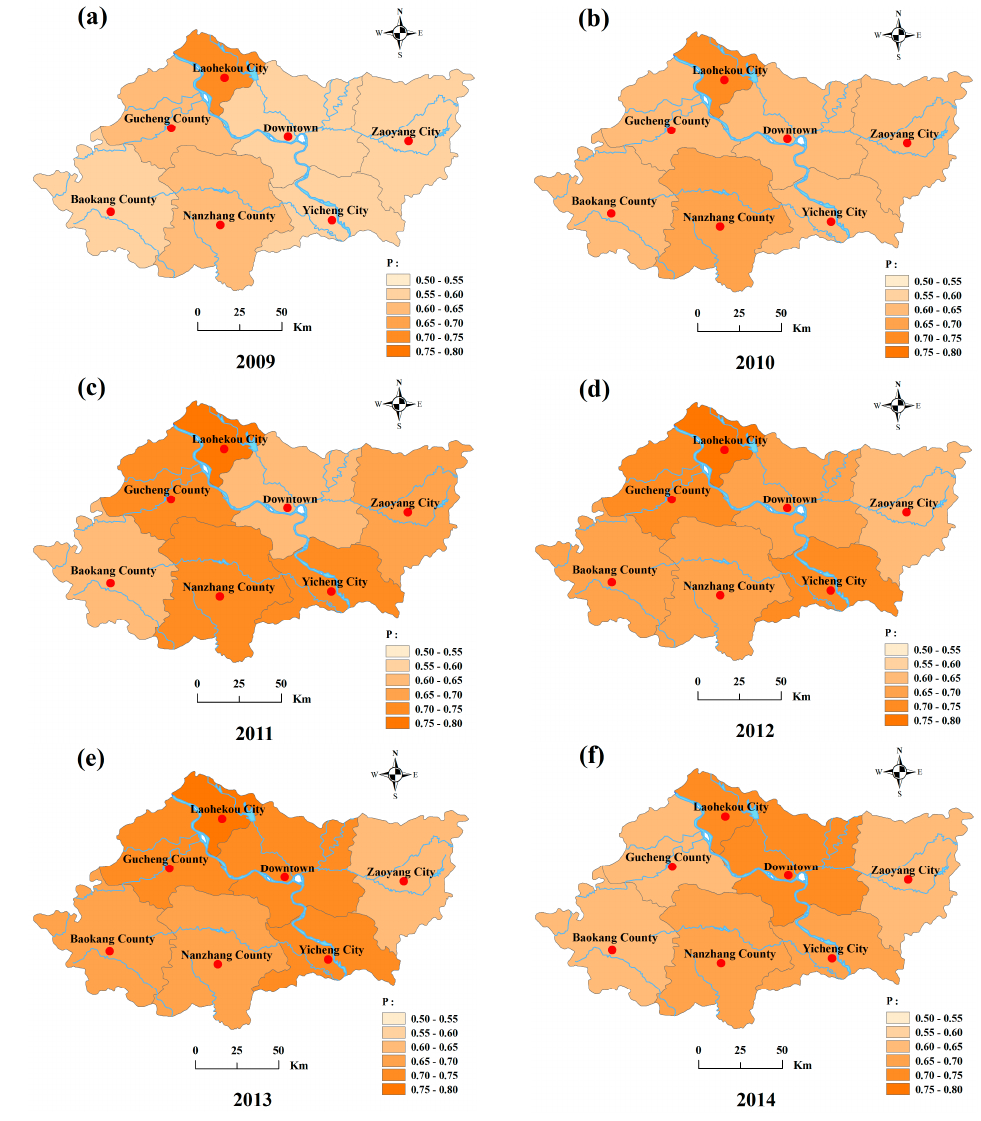
Figure 9. Spatial distribution pattern of the overall harmonious development index in Xiangyang City during 2009~2014. ( a ) 2009; ( b ) 2010; ( c ) 2011; ( d ) 2012; ( e ) 2013; ( f ) 2014.